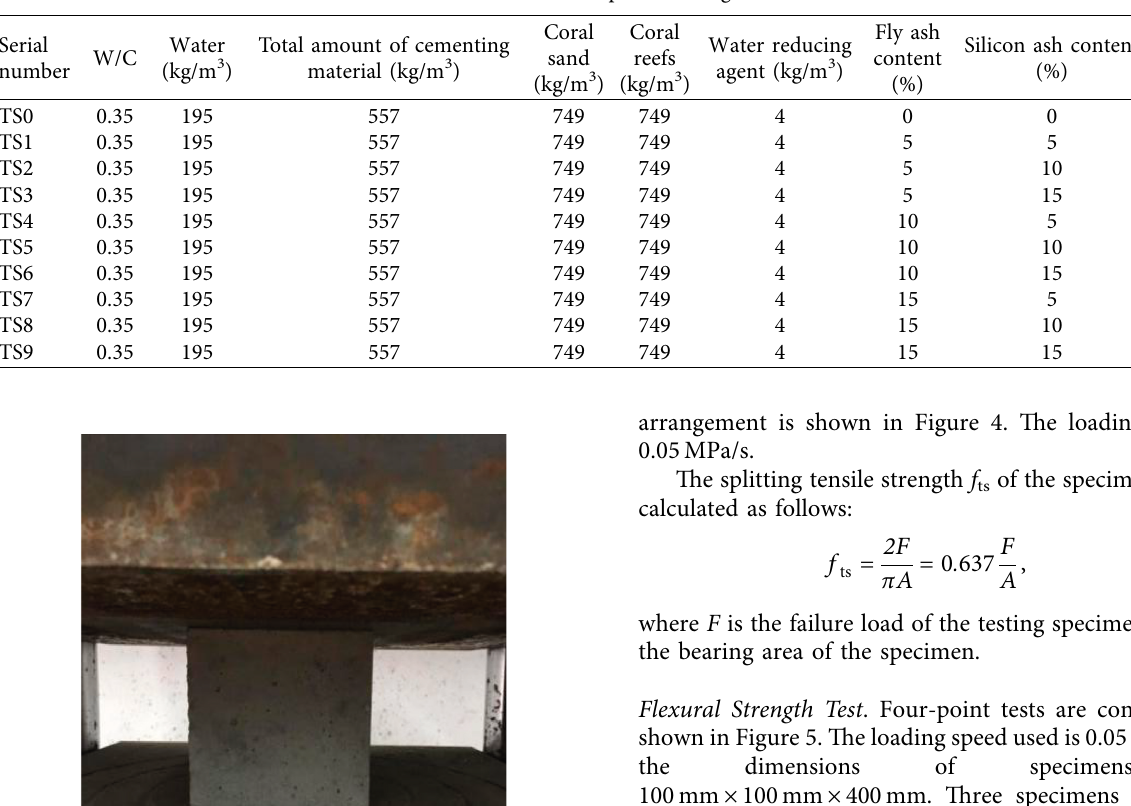
Table 4: Sample mix design.